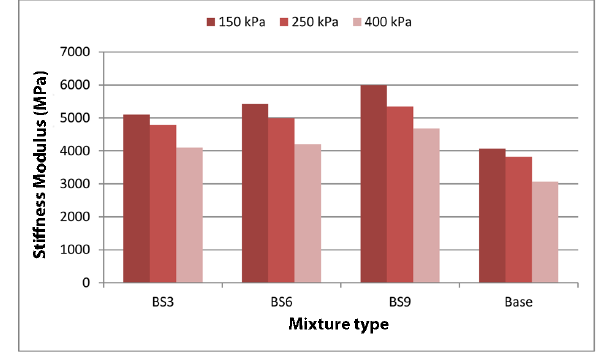
Fig. 9. Fatigue life of various modified binders at strain level of 2.5%